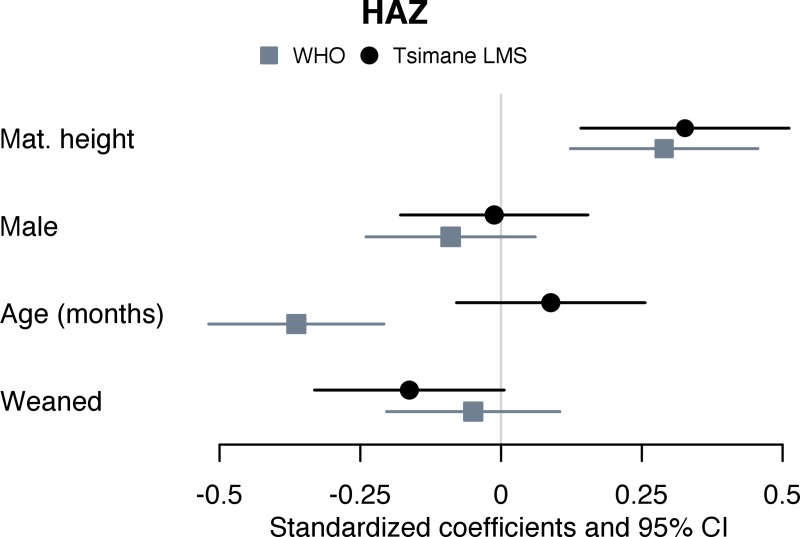
Forest plot of coefficient estimates from Models 9a-9b (mean and 95% CI).Mixed-effects liner regressions on WHO- and Tsimane-derived HAZ scores in children 6–35 months, with random intercept for subject (n subjects = 129; n observations = 198). Independent variables included maternal height (cm); infant sex (male vs. female); child age at measurement; and weaning status (weaned vs. still breastfeeding).